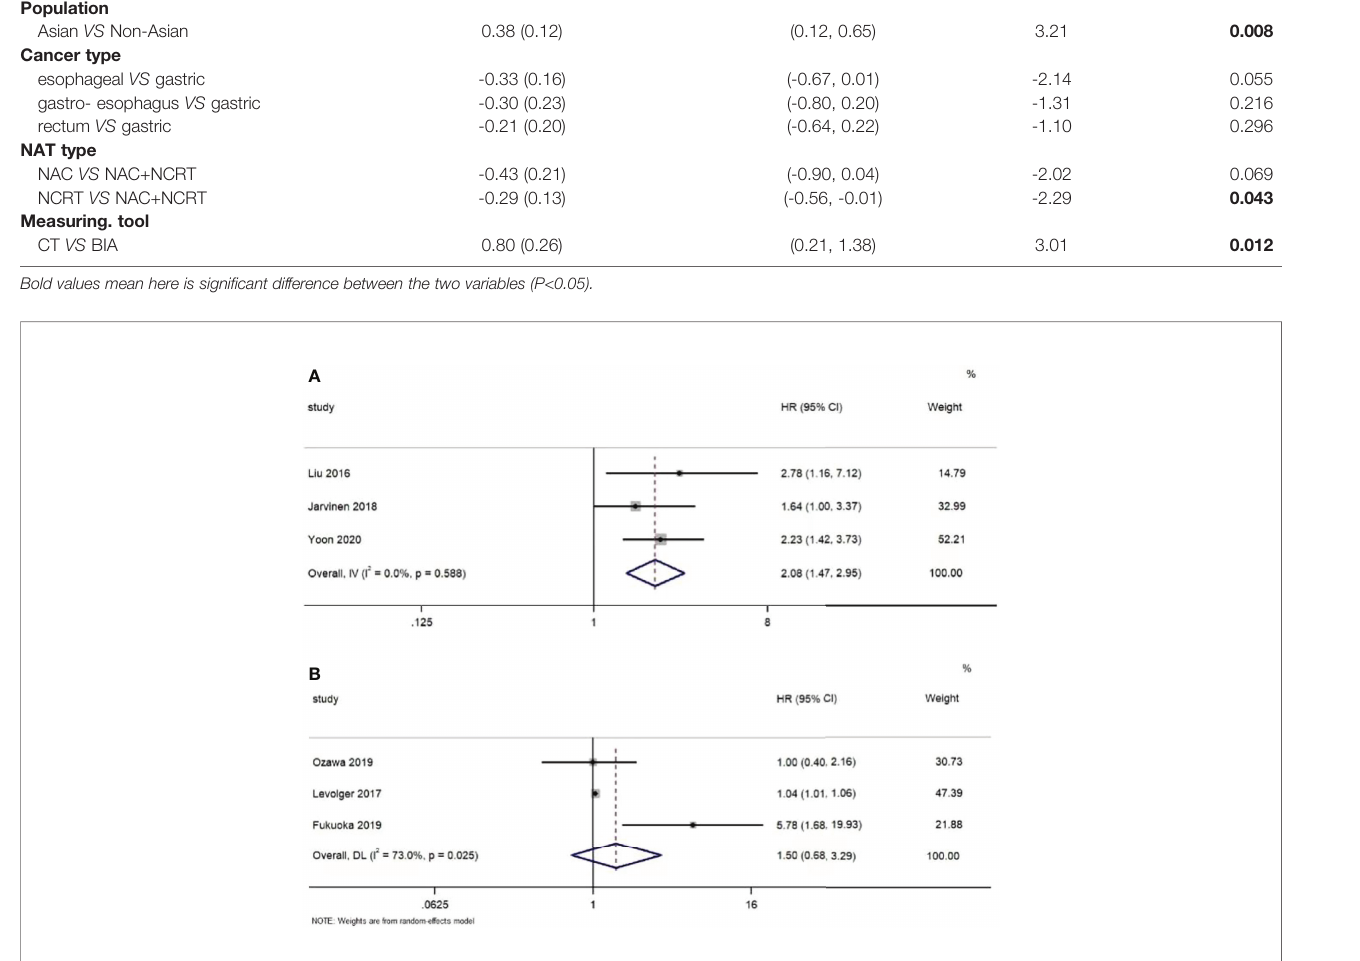
FIGURE 4 | Forest plots of the relationship between muscle loss during neoadjuvant therapy and (A) overall survival and (B) disease-free